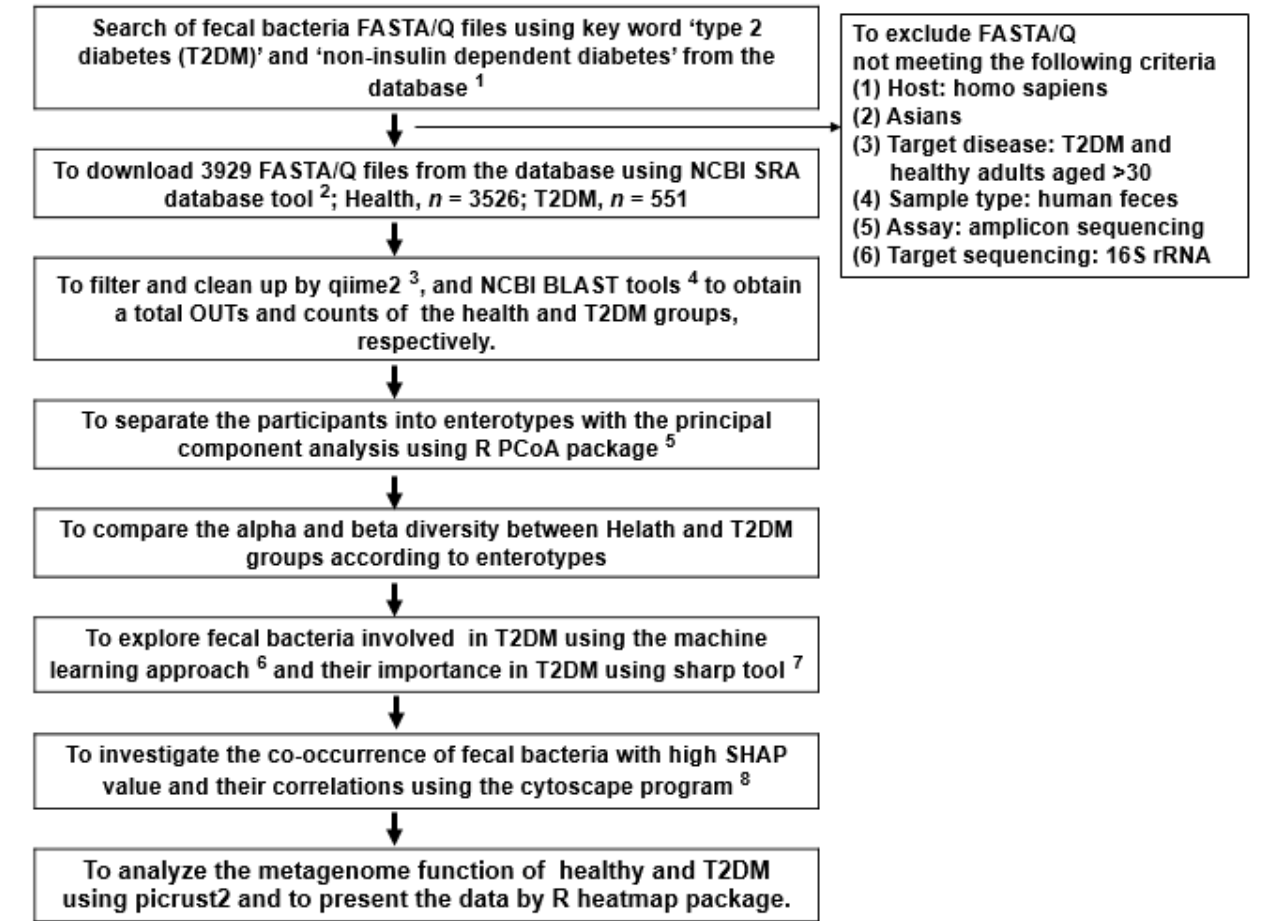
Figure 1. A flow chart of the overall fecal FASTA/Q selection process and analysis methods. 1